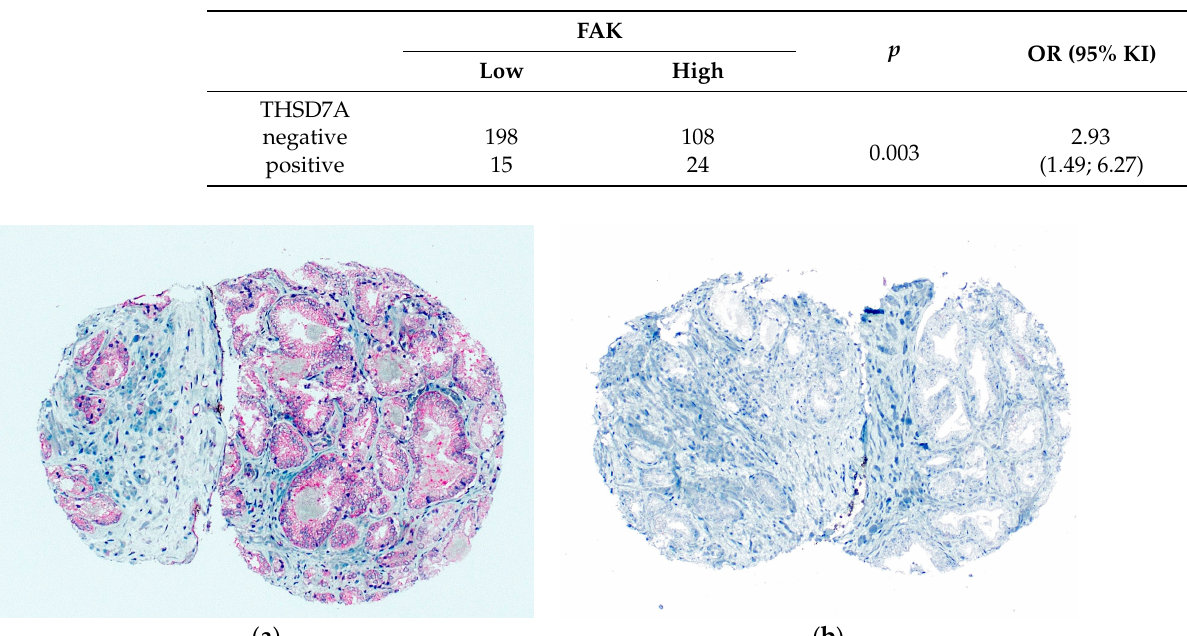
Figure 3. ( a ) Tumor with high FAK expression; ( b ) same tumor is THSD7A-negative with a magni- fication of 100×.